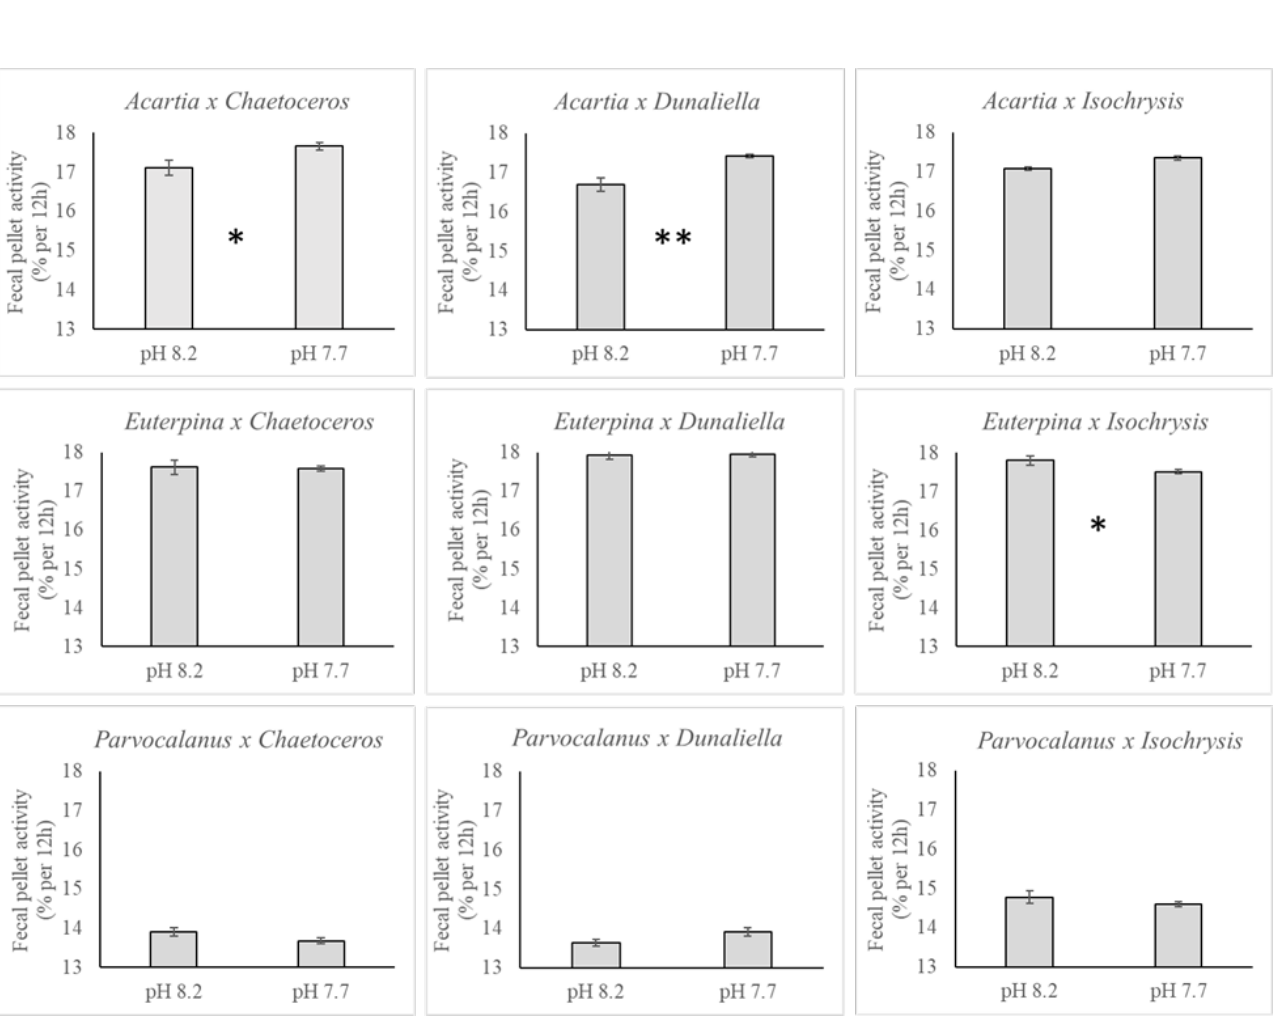
Figure 4. Effect of pH on polonium activity in the copepod fecal pellets (in % per 12 h) for each combination of copepod ( Acartia pacifica, Euterpina acutifrons and Parvocalanus crassirostis ) and mi- croalgae species ( Chaetoceros muelleri, Dunaliella salina and Isochrysis galbana ). Results are presented as mean±SEM. Significant difference between pH treatments are indicated with * (ANOVA; p<0.05) and ** (p < 0.01).